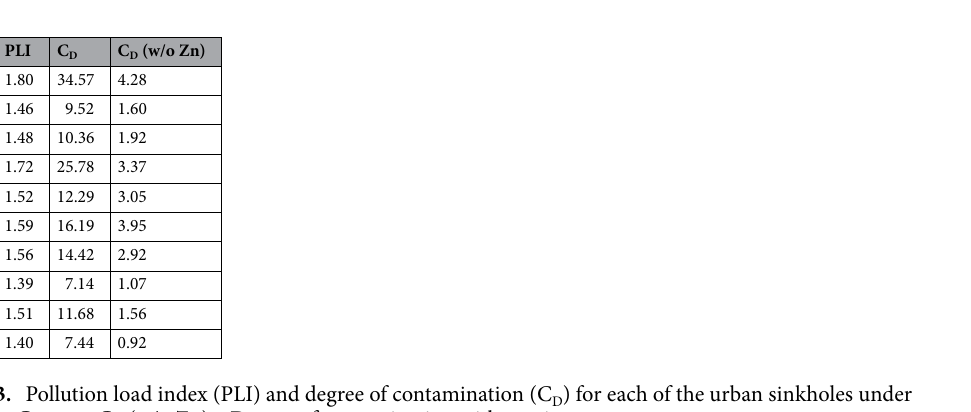
Table 3. Pollution load index (PLI) and degree of contamination (C D ) for each of the urban sinkholes under study in Cancun. C D (w/o Zn)—Degree of contamination without zinc.